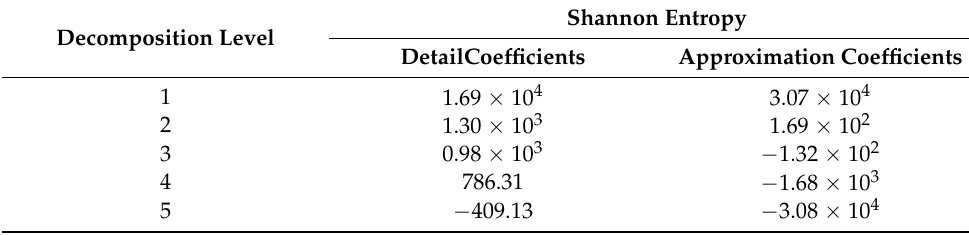
Table 4. Shannon entropy value corresponding to the different decomposition levels (mother wavelet: “ fk6